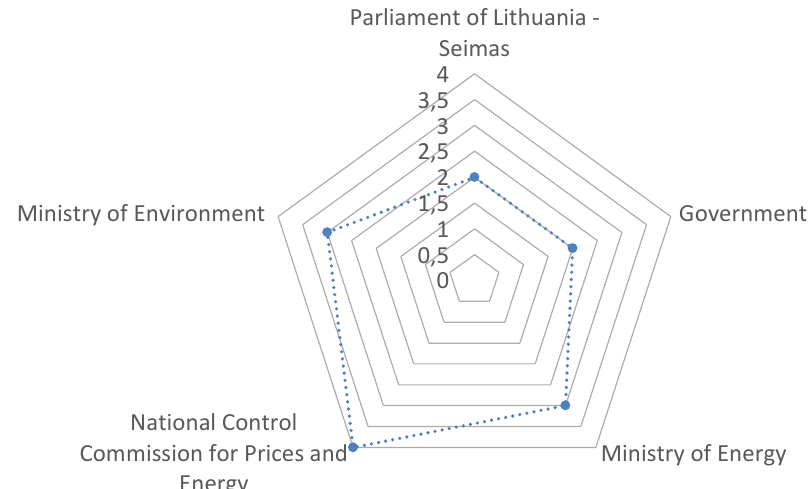
Figure 2. Citizen participation levels in the electricity sector governance in